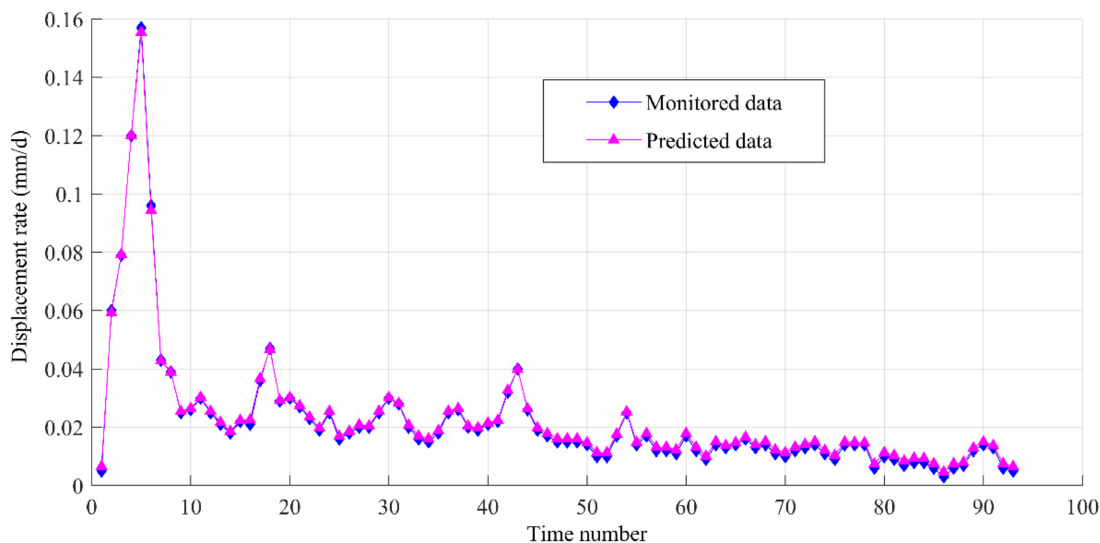
Figure 7. The monitored and predicted displacement rate of two-factor (displacement rate and rainfall) SVRM model over time.